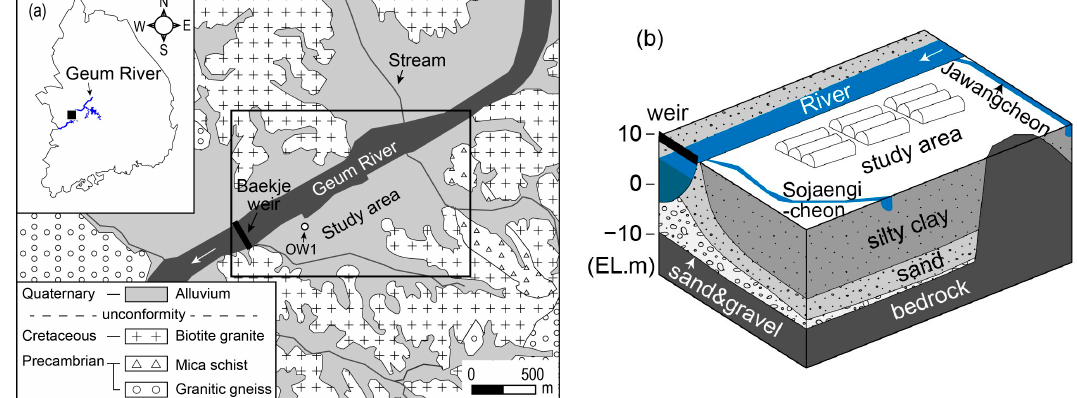
Figure 1. ( a ) Location and geological map of the study region in the Geum River Basin, South Korea (modified from [30]); ( b ) Characteristics of the alluvial successions.